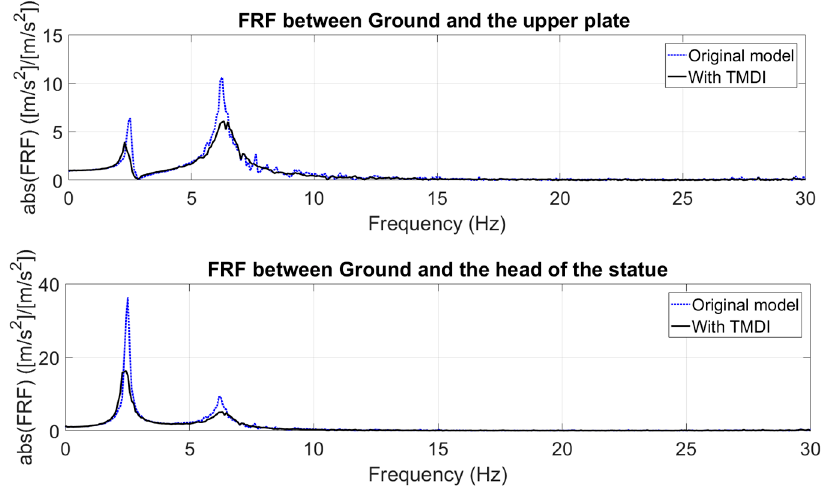
Figure 17. FRFs obtained from MDOF model without and with TMDIs for case 2 in Table 3; the excitation is the El Centro earthquake.